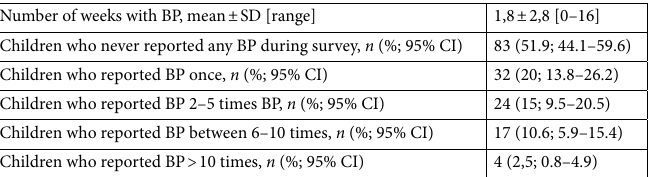
Number of weeks with BP, mean ± SD [range] 1,8 ± 2,8 [0–16] Children who never reported any BP during survey, n (%; 95% CI) 83 (51.9; 44.1–59.6) Children who reported BP once, n (%; 95% CI) Children who reported BP 2–5 times BP, n (%; 95% CI) Children who reported BP between 6–10 times, n (%; 95%